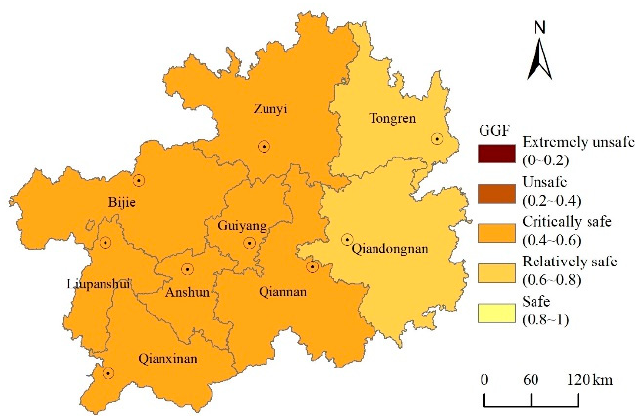
Figure 9. Spatial distribution of the GGFI (Geological and Geomorphological Features Index) in cities and states in Guizhou Province in various cities and states in Guizhou Province in 2010.